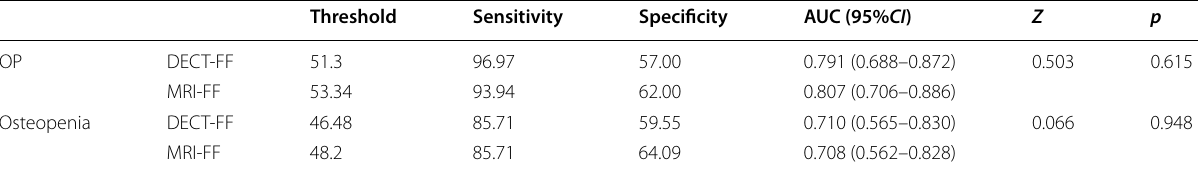
Table 2 Comparison of DECT-FF and MRI-FF in the evaluation of OP and osteopenia (n